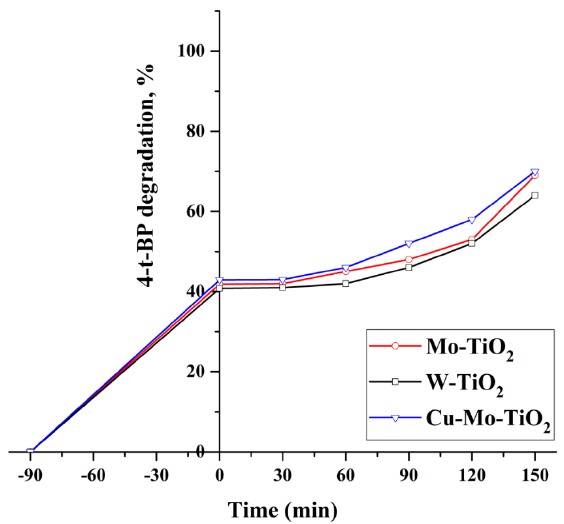
2 and Cu-Mo-TiO 2 .